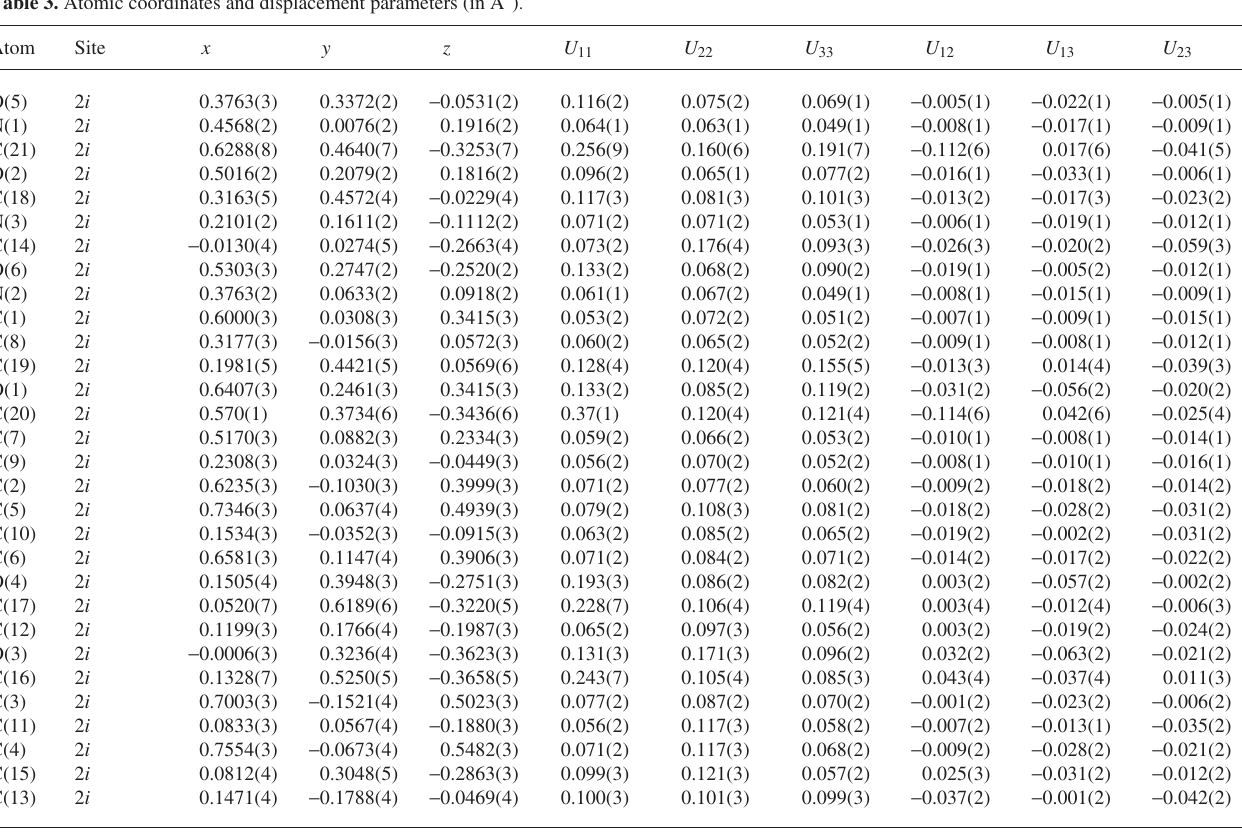
Table 3. Atomic coordinates and displacement parameters (in Å 2 )